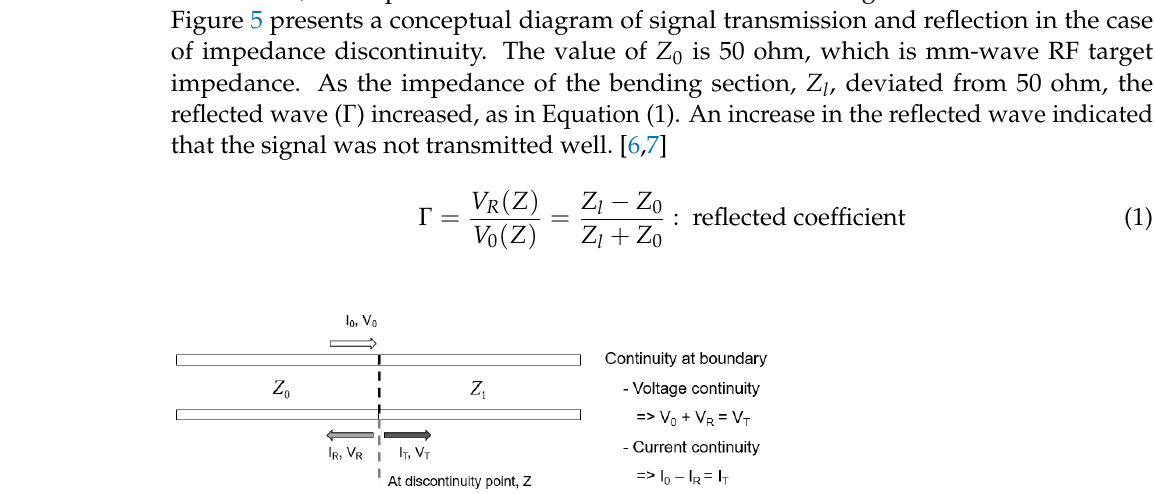
Figure 4. Return current densities of outer copper. ( a ) Current density without outer copper crack; ( b ) Current density with 1 um outer copper crack and an attached anisotropic conductive adhesive; and ( c ) Current density with 1 um outer copper crack and an attached isotropic conductive adhesive. Fourth, the impedance deviation before and after bending should be less than 10%.